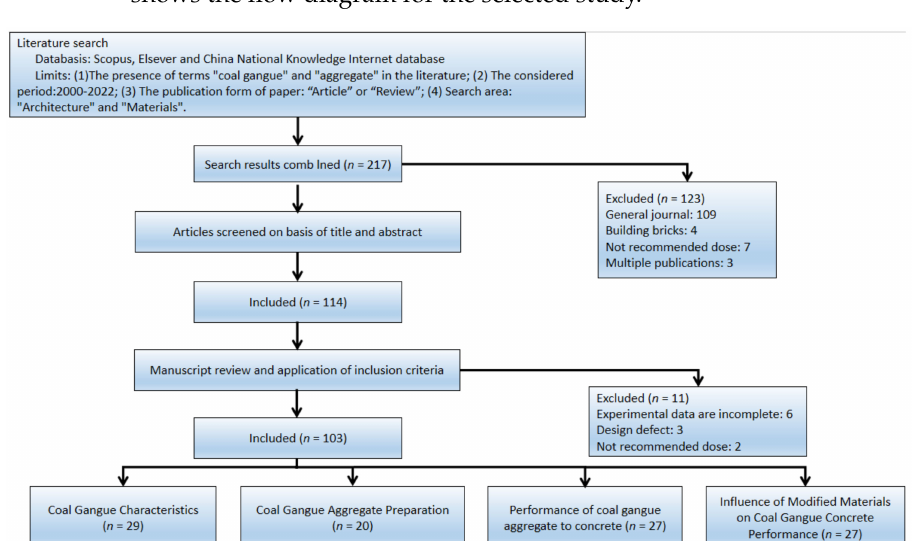
Figure 3. Flow diagram of the study selected.